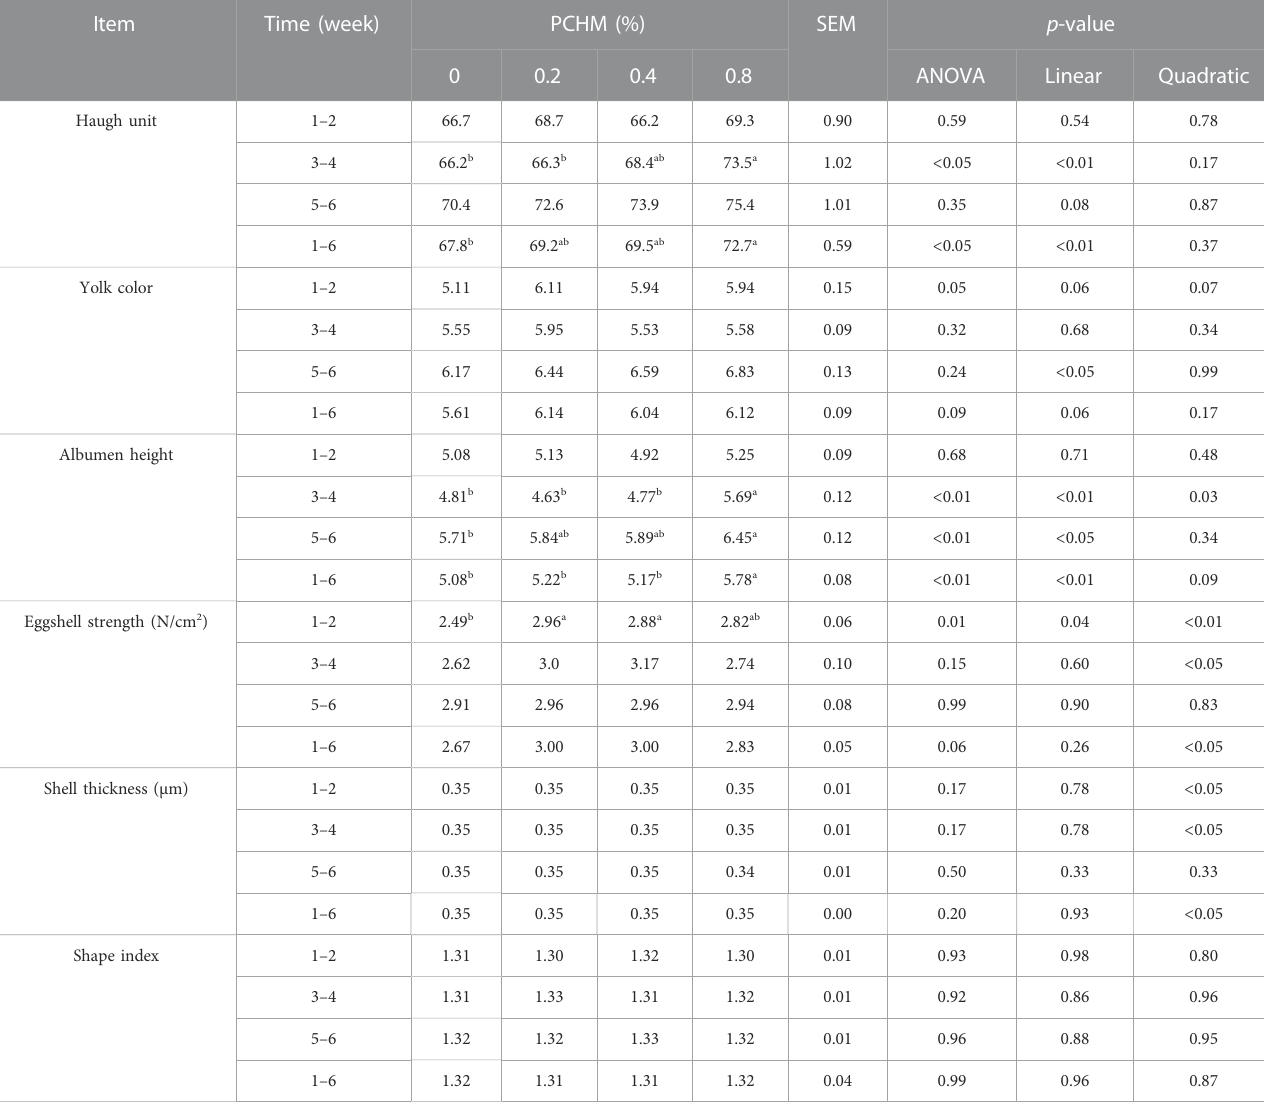
TABLE 6 Effect of dietary PCHM supplementation on egg quality.